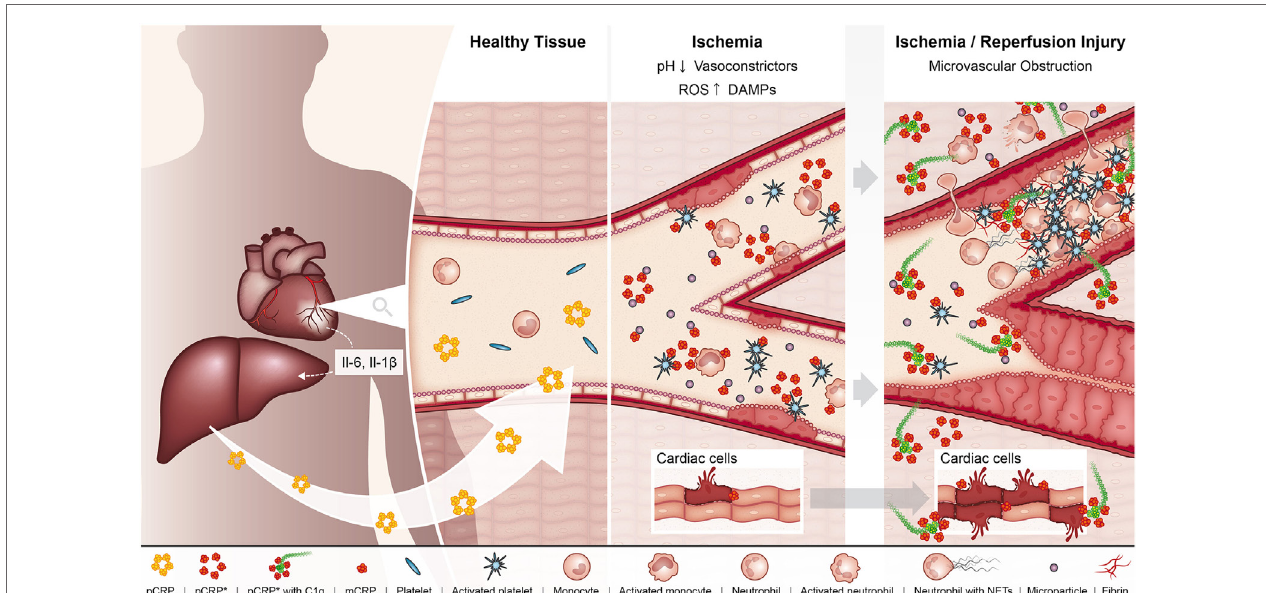
FiGURe 2 | In the setting of myocardial ischemia, the hepatic production of pCRP is upregulated under the regulation of interleukin 6 (IL-6). pCRP circulates in the blood, where it can interact with MPs, activated platelets, leukocytes, and endothelial cells in the ischemic myocardium, which triggers the dissociation of pCRP to its pro-inflammatory forms pCRP* and monomeric CRP (mCRP). In turn, these pro-inflammatory structural isoforms of CRP aggravate tissue injury by promoting the adhesion of leukocytes and platelet deposition to the ischemic endothelium, ultimately resulting in the formation of microvascular thrombi and thus microvascular obstruction. In addition, pCRP*/mCRP enhances leukocyte transmigration where infiltrating leukocytes degranulate and exacerbate tissue injury. pCRP*/mCRP also activate complement, which can directly mediate tissue injury via formation of the membrane attack complex. These pro-inflammatory effects of CRP ultimately result in enhanced myocardial injury and impaired organ